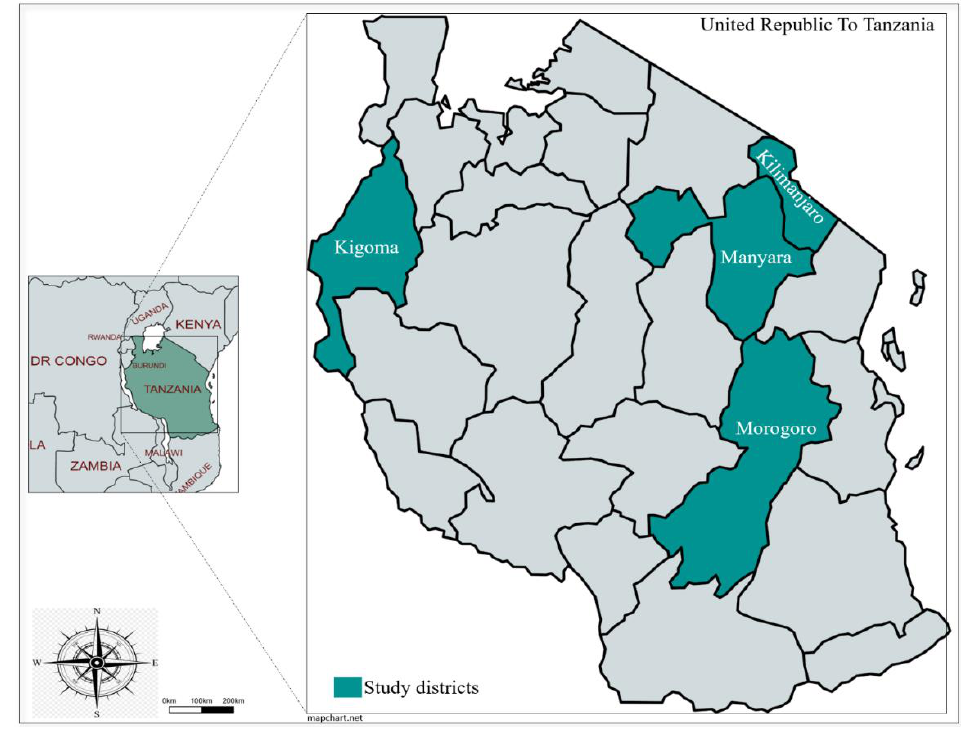
Figure 1. Map of Tanzania: the study districts are highlighted in green.